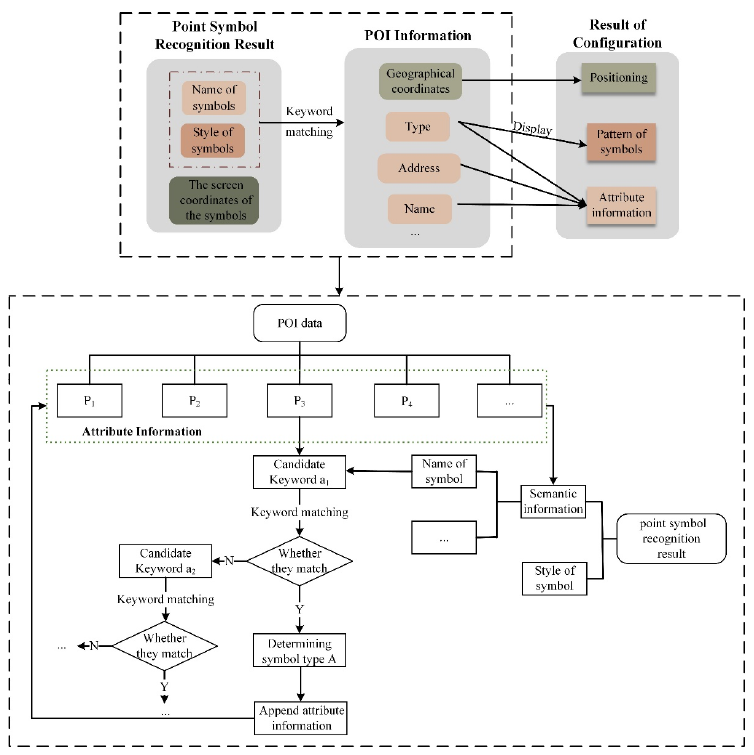
Figure 3. Map point symbols automatic positioning configuration process.